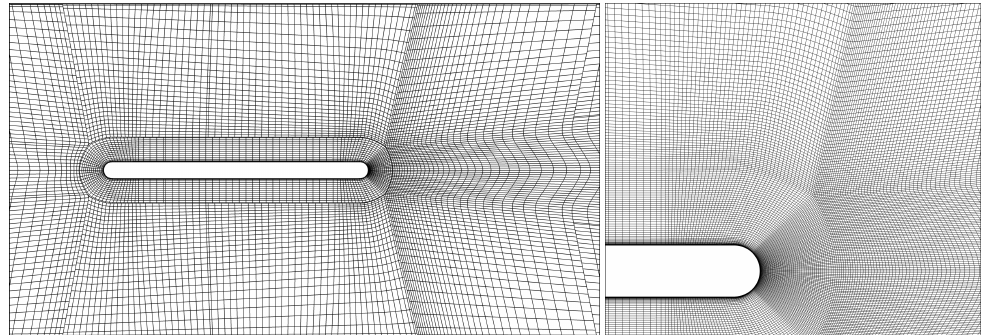
Figure 2. Section of the computational domain with every third grid line shown ( left ) and close-up of the region around the trailing edge with every grid line shown ( right